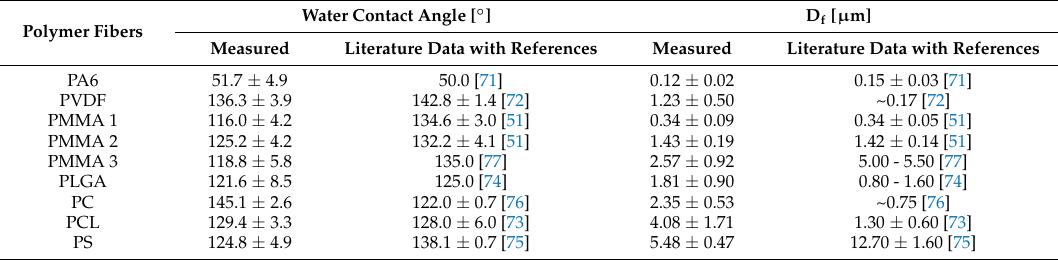
Table 5. Water contact angle on electrospun polymer fibers with D f as compared with the literature data. Polymer Fibers